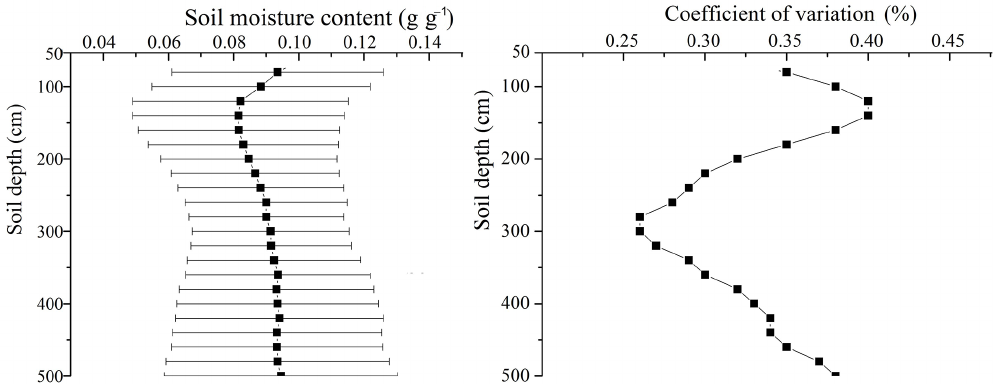
Figure 3. Profile distribution of the deep soil moisture contents and coefficients of variation. The error bars indicate the standard deviation. Table 3. Summary statistics of the deep soil moisture at various depths in the Ansai